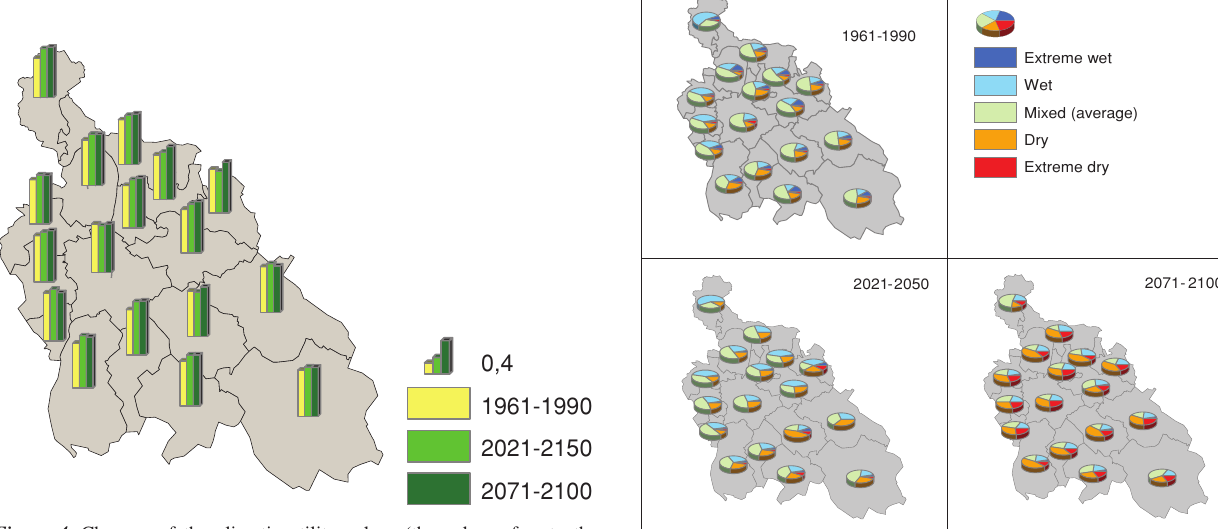
Figure 4. Changes of the climatic utility values (the value refers to the highest column in the chart symbol) Figure 6. Changes of climatic year types regarding precipitation